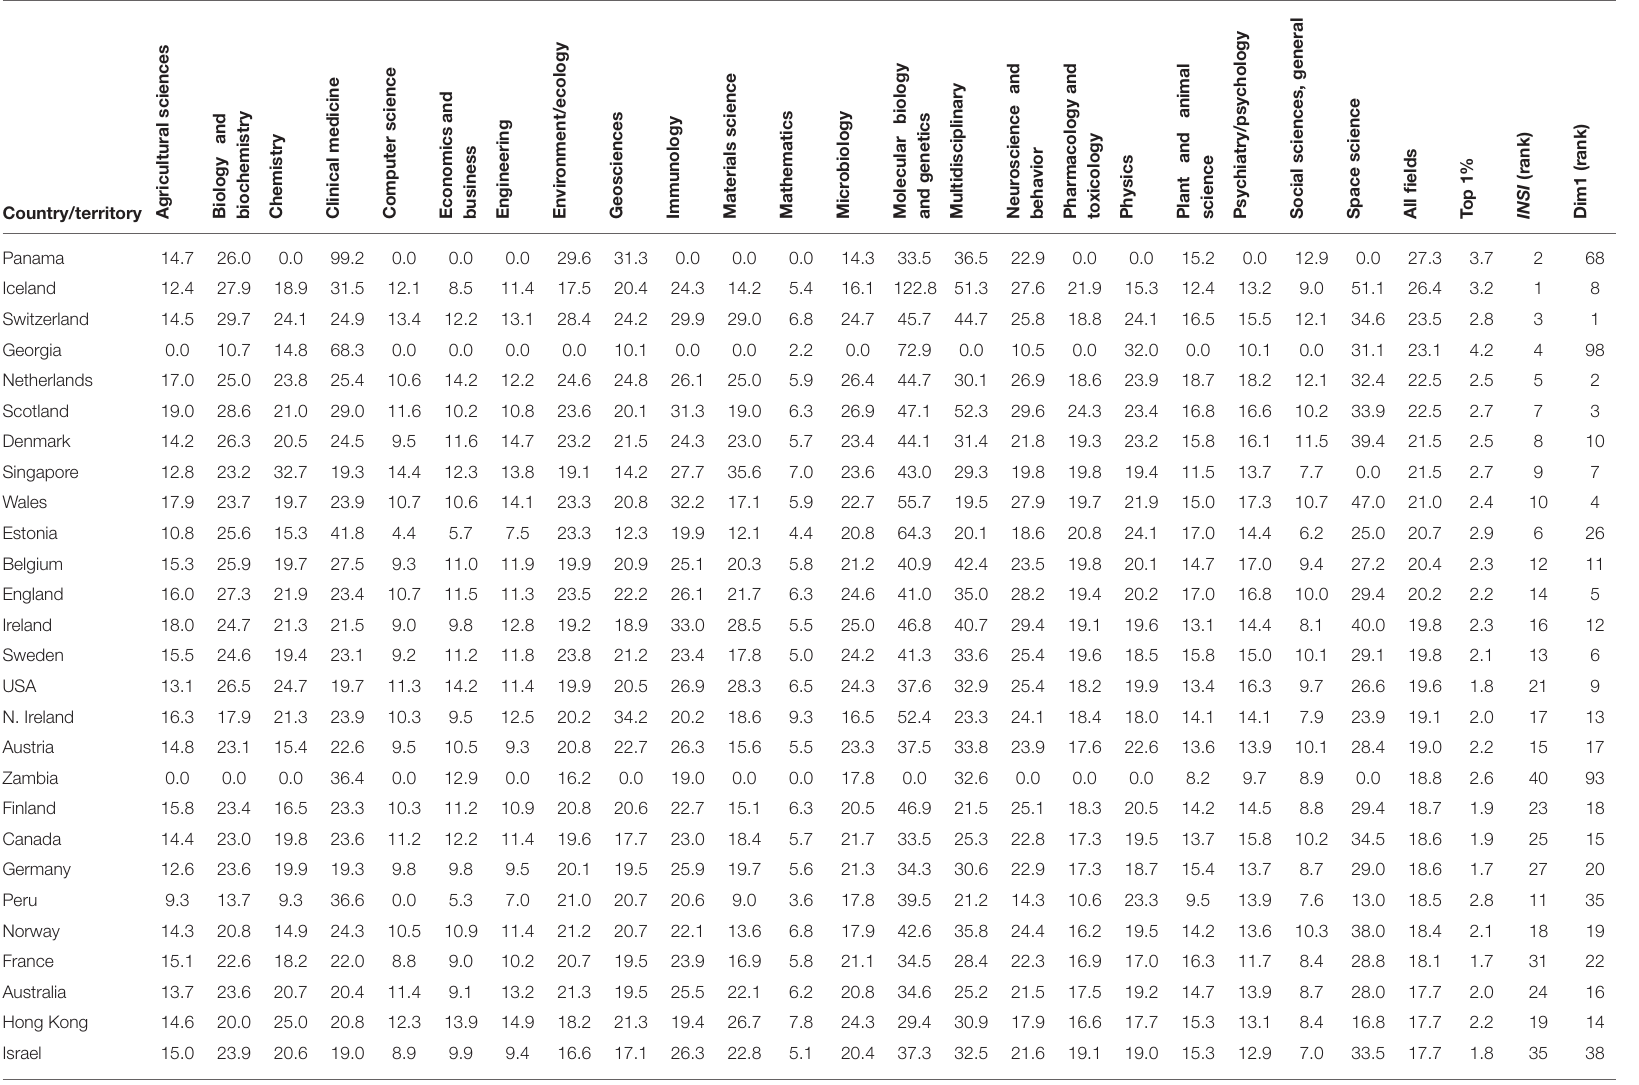
TABLE 1 | The mean citation rates in 22 research fields and the average citation rate for 107 countries/territories that published 3,000 or more papers able to enter the ESI for the period 2009–2019.